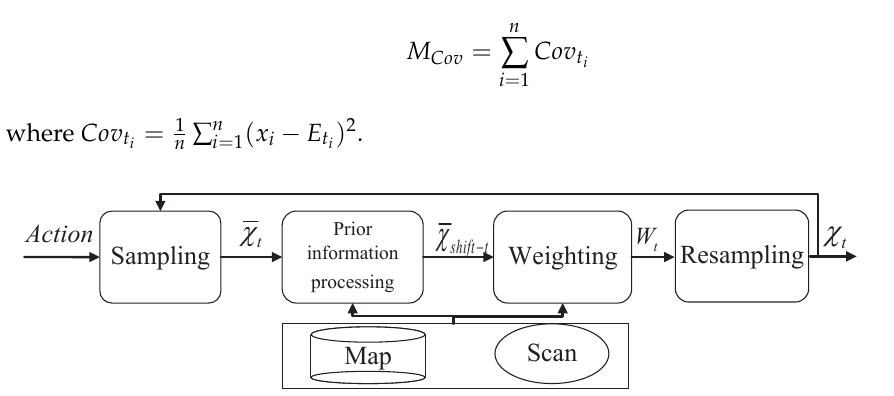
Figure 3. The PSF localization